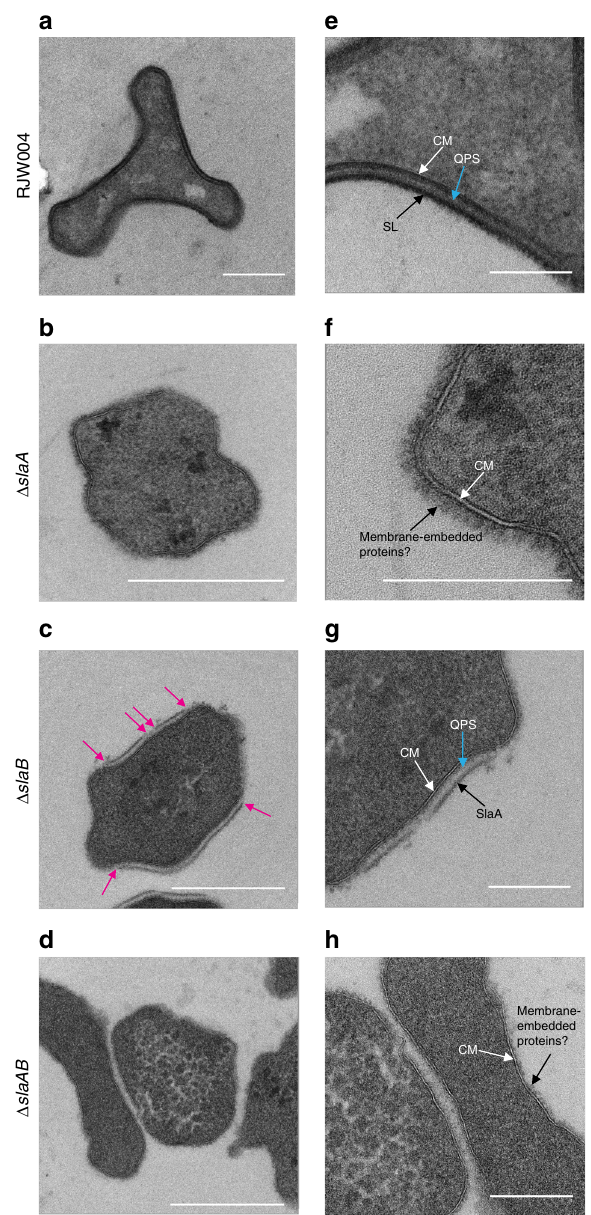
Fig. 4 Thin-section TEM analysis of the wild-type and S-layer gene knockout strains. a – d Representative TEM micrographs of thin-sectioned cells of the wild-type, Δ slaA , Δ slaB , and Δ slaAB mutant strains, respectively. Images e – h are closeups of images a – d , respectively. Magenta arrows indicate the breaking points of S-layer. CM cytoplasmic membrane, SL surface layer, QPS quasi-periplasmic space, SlaA surface layer protein